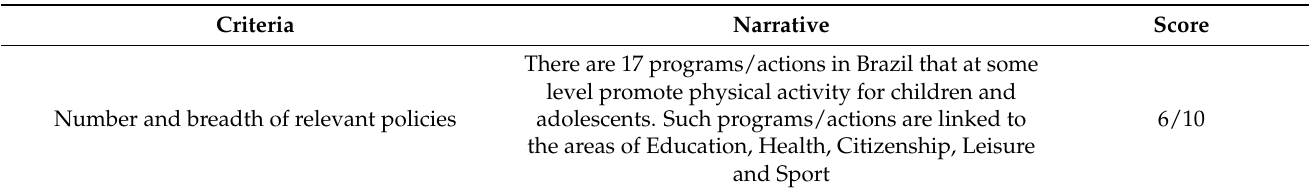
Table 3. Description of the Health Enhancing Physical Activity (HEPA) Policy Audit Tool (PAT) score for physical activity programs/actions in